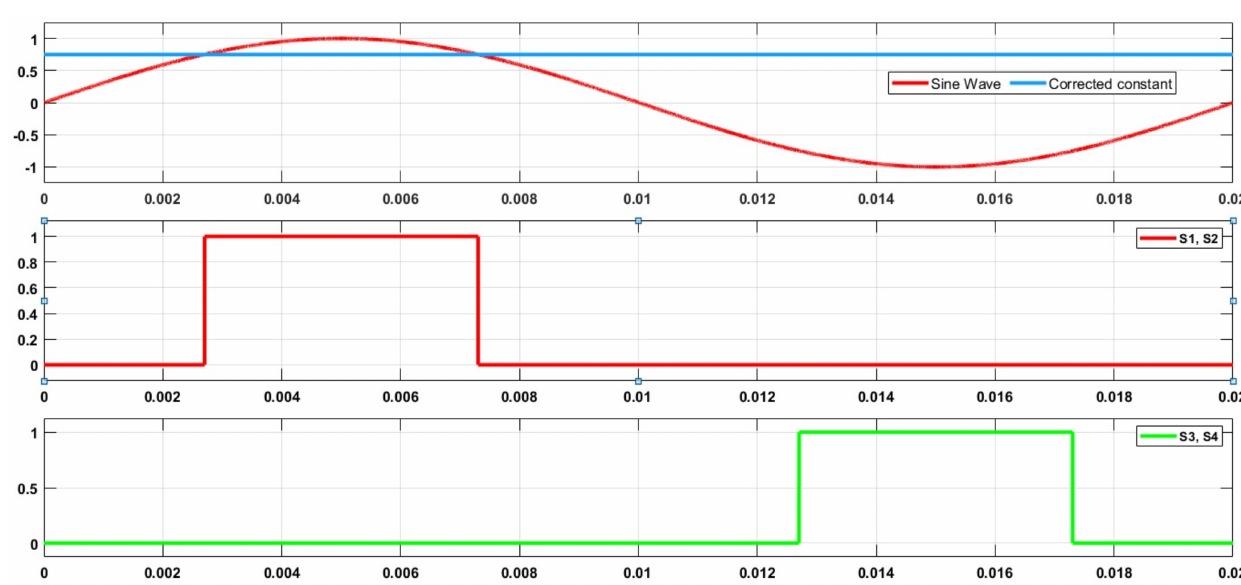
Figure 9. Phase-shifted pulse generation from the QWS